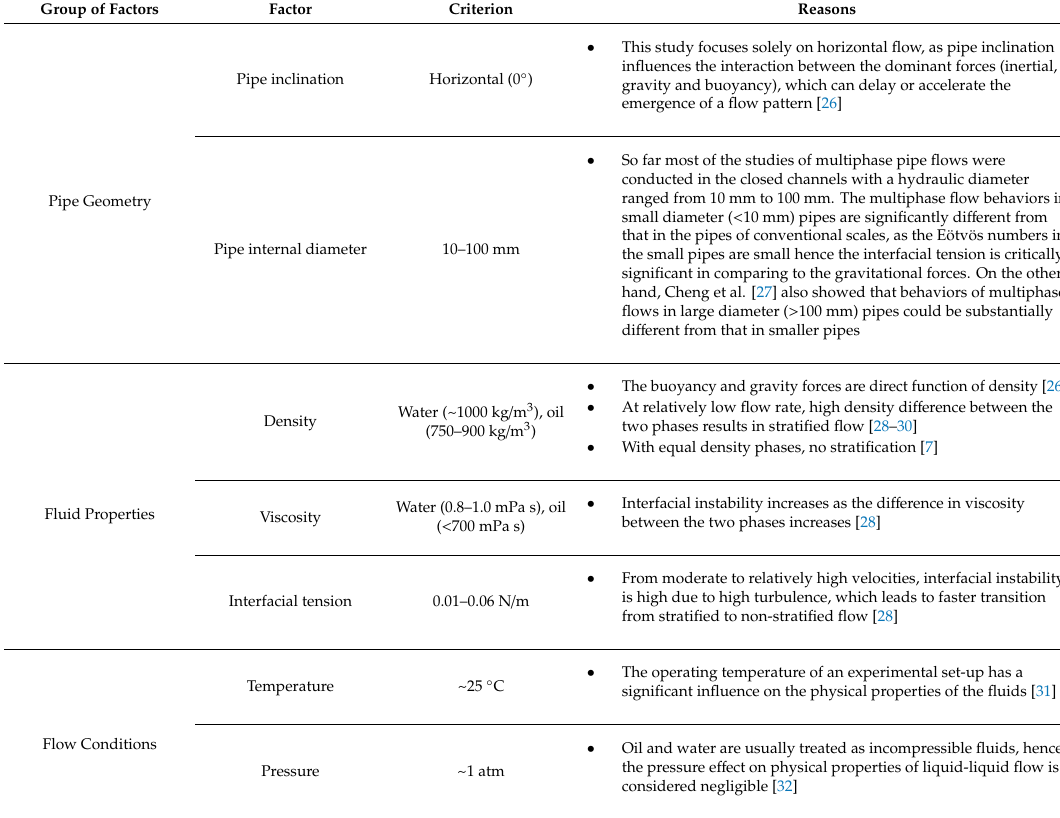
Table 1. Main conditions for including an experimental